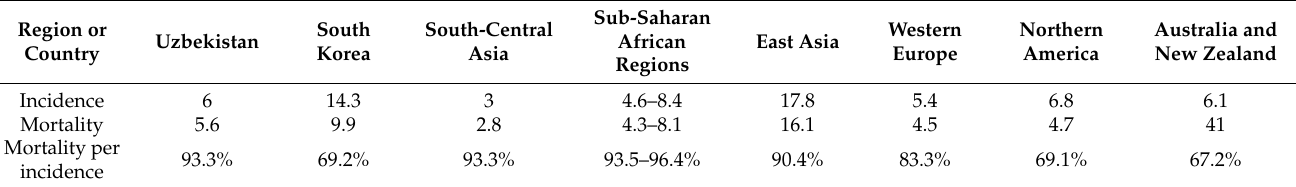
Table 2. Brief global statistics of liver cancer including Uzbekistan and South